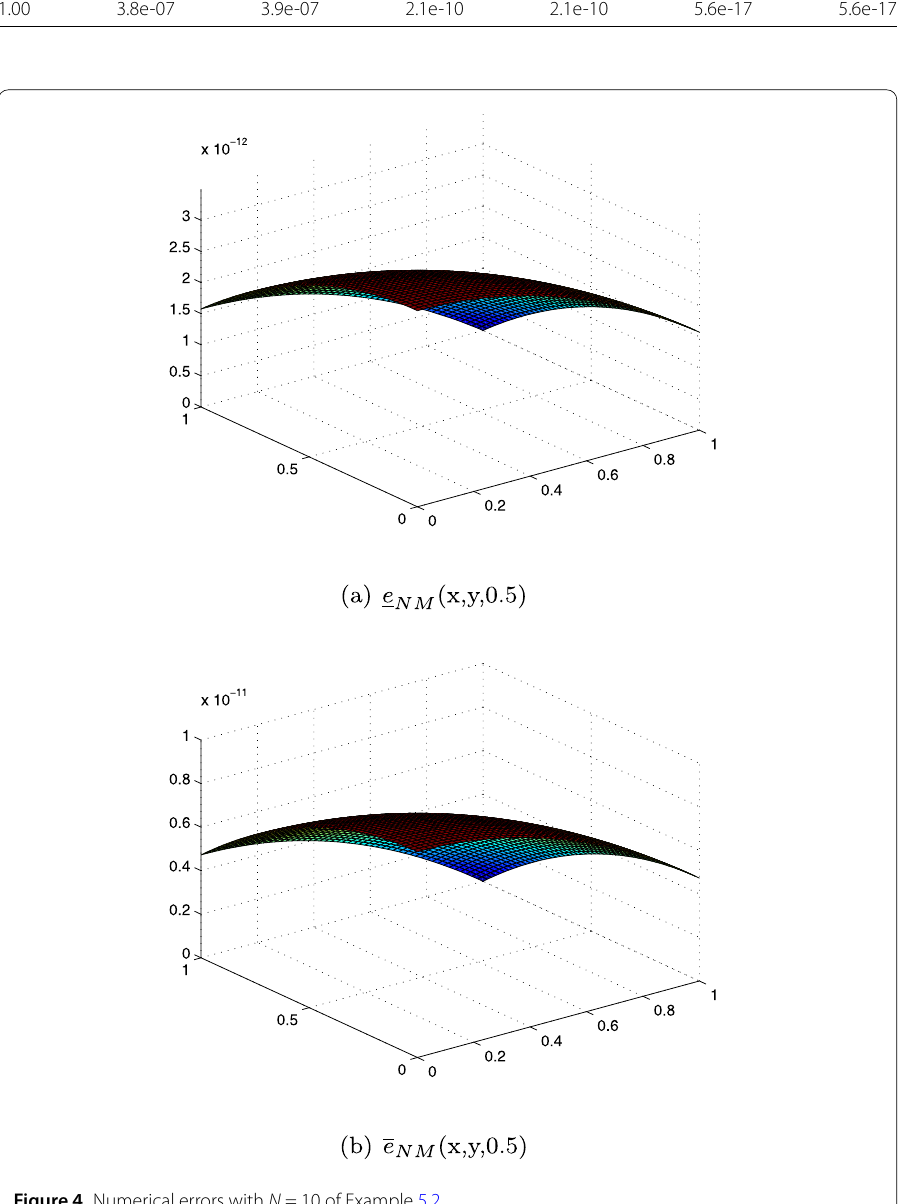
suggests that the condition number of the discrete coefficient matrix remains unchanged under different values of M = N . In Fig. 6 we plotted the numerical solutions and exact solutions for M = N =